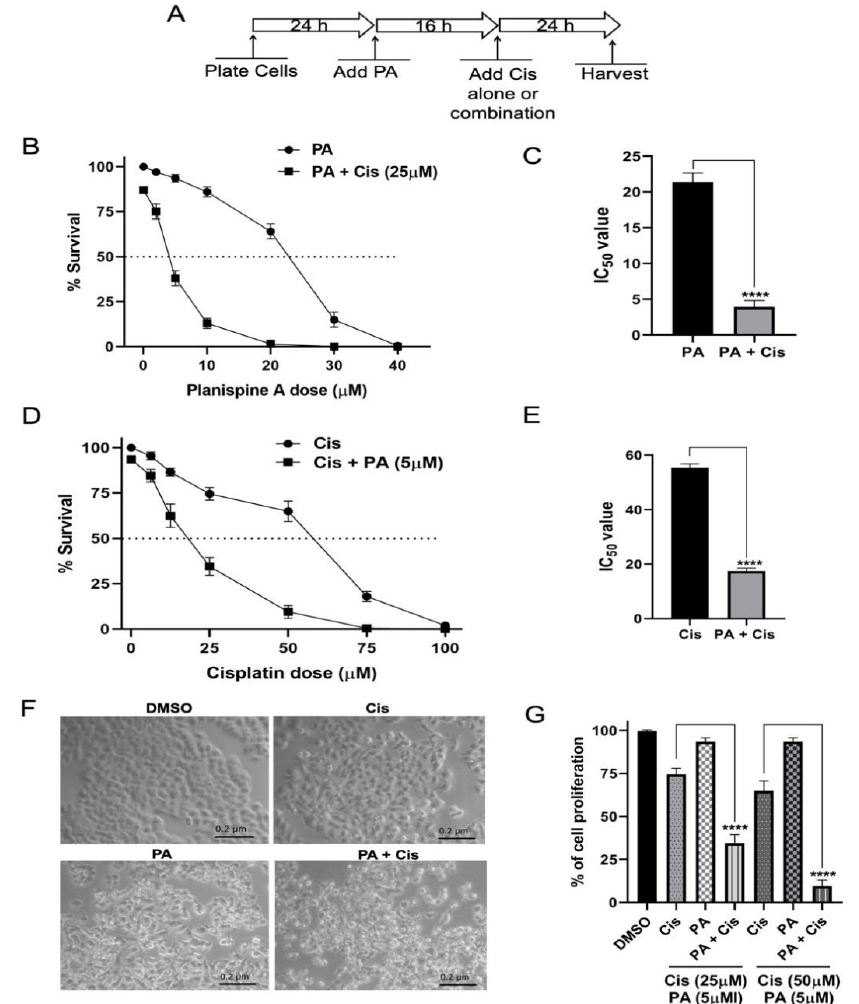
Figure 3. Planispine A acts in synergism with cisplatin. ( A ) Schematic protocol for the combination treatment. ( B ) Dose-dependent inhibition of cell proliferation by planispine A or in combination with cisplatin (25 μ M). ( C ) Graph representing IC 50 . ( D ) Dose-dependent inhibition of cell proliferation by cisplatin or in combination with planispine A (5 µ M). ( E ) Graph representing IC 50 values. ( F ) Microscopy image showing morphology of cells when treated alone or combination with planispine A and cisplatin (20X). Scale bar, 0.2 µ m. Cells were treated with DMSO (control), cis (cisplatin, 25 µ M), PA (planispine A, 5 µ M) or a combination. ( G ) Quantification of cell proliferation assay. Cells were pre-treated with PA (5 µ M) for 16 h before treatment with cis (25 and 50 µ M) for 64 h. Data represent percentage of growth compared with DMSO. **** p < 0.0001 vs.